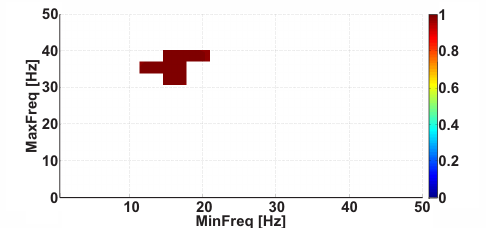
Figure 19. The Frequency 2D AUC diagram that corresponds to the horizontal slice of the 3D AUC diagram (see Figure 18) at the resolution R = 15. This Frequency 2D AUC diagram includes only the points that correspond to statistically significant differences between the groups of subjects. The abscissa axis indicates the lower bound of the frequency range; the ordinate axis indicates the upper bound of the frequency